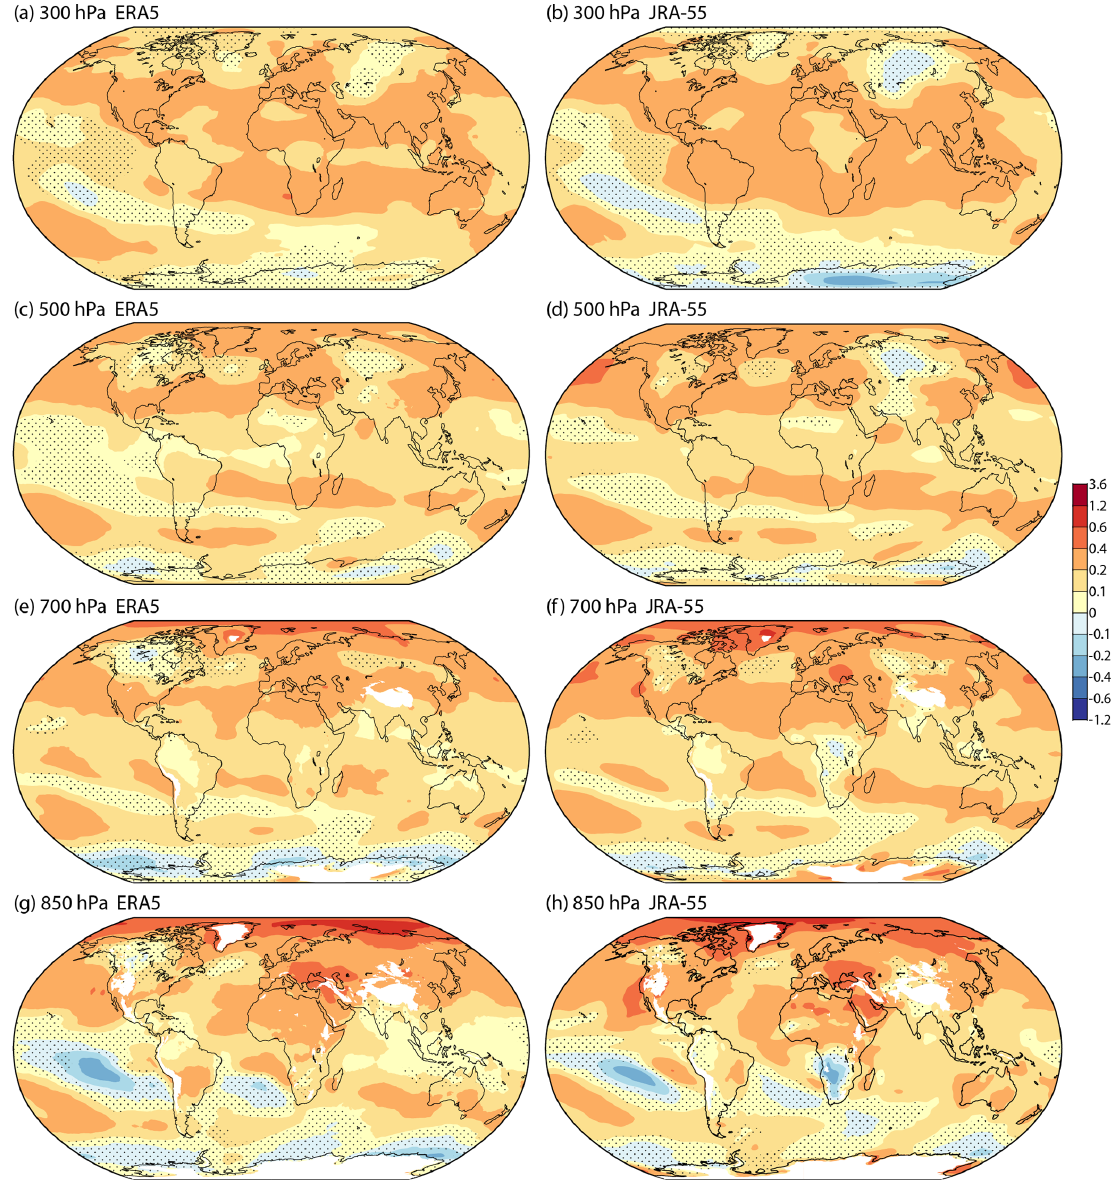
Figure 4. The least squares linear trend (K per decade) in monthly average ERA5 (left) and JRA-55 (right) temperatures from March 1979 to February 2022 for (a, b) 300hPa, (c, d) 500hPa, (e, f) 700hPa and (g, h) 850hPa. Dots show where the 95% confidence interval is two-signed. Regions where the ERA5 model orography exceeds 1500m (for 850hPa) or 3000m (for 700hPa) are masked in